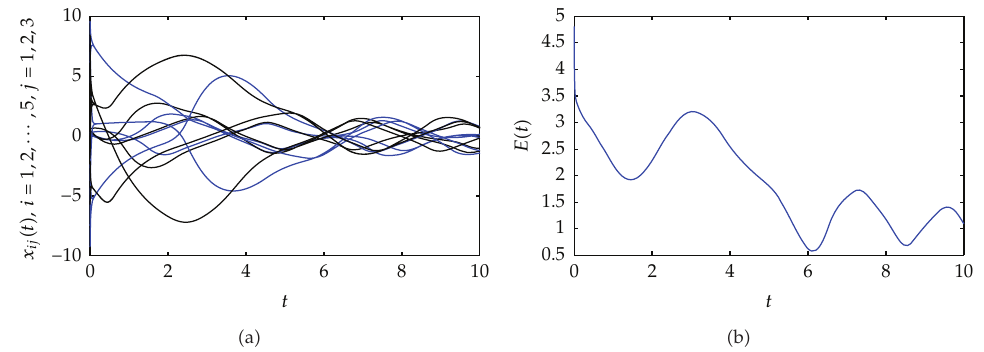
Figure 6: The trajectory of a nonlinearly coupled Hopfield neural network without pinning control. (cid:6) a (cid:7) The states of the nodes. (cid:6) b (cid:7) The error dynamics of the above Hopfield neural